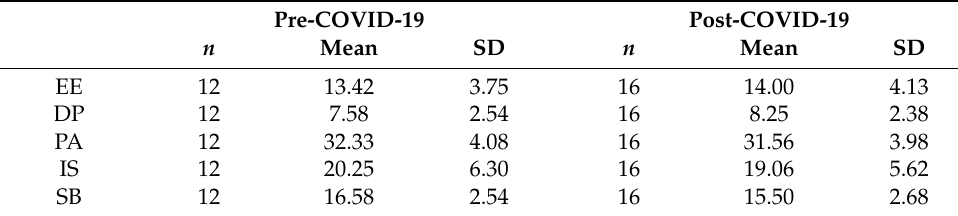
Table 4. Results of the dimensions before and after